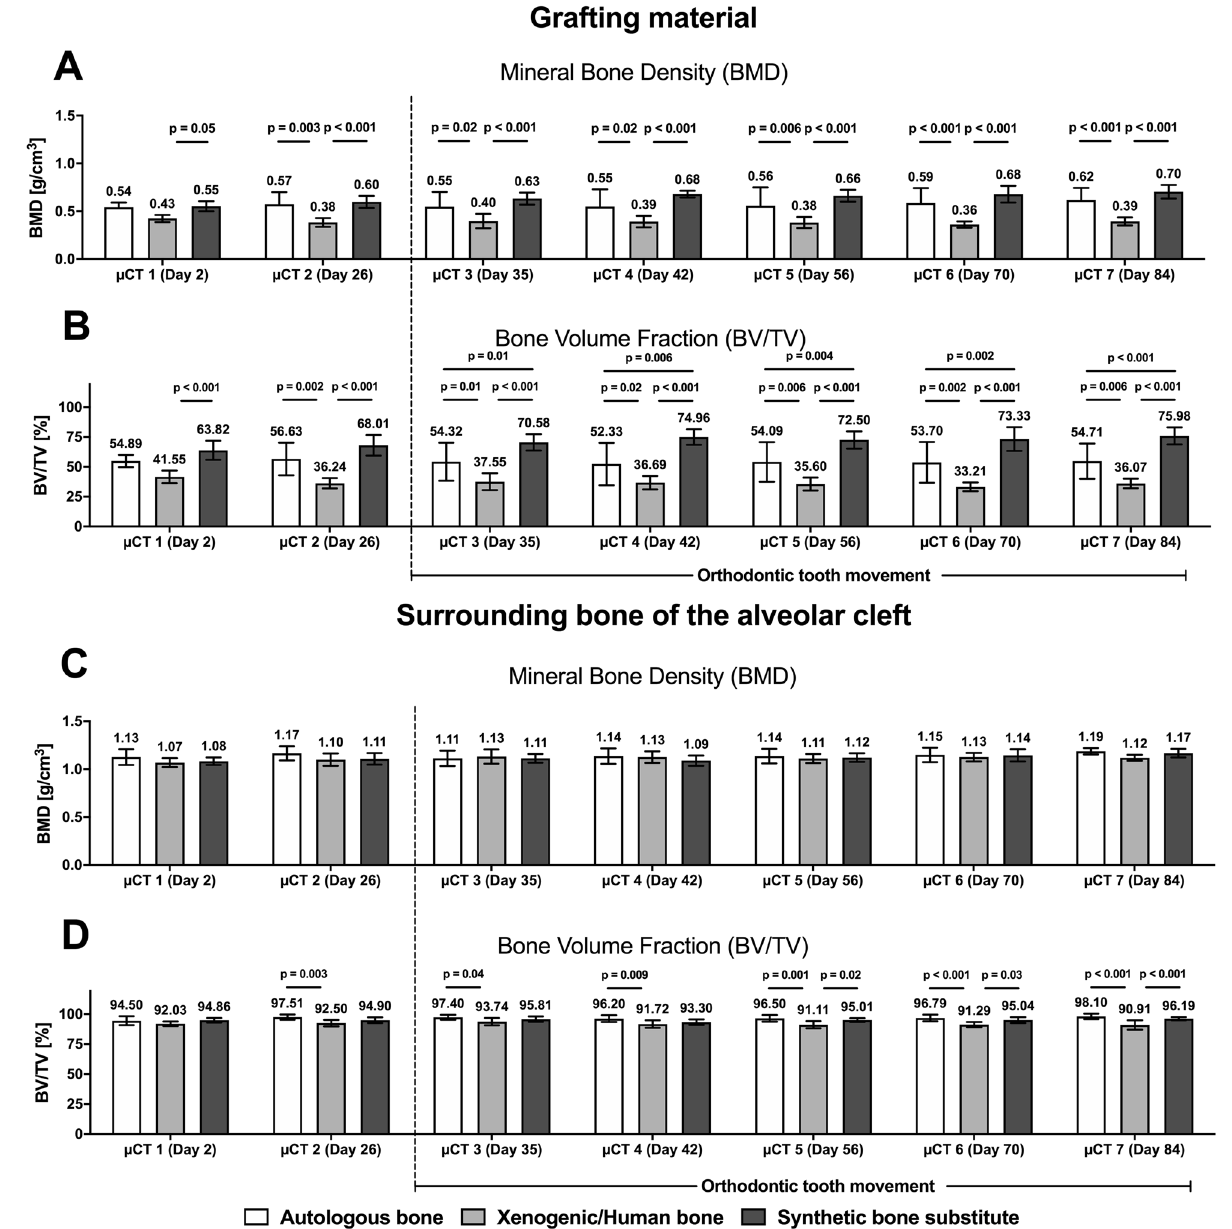
Figure 7. Radiological changes of the bone mineral density (BMD) and bone volume fraction (BV/TV) in the grafting materials ( A , B ) and in the bone surrounding the cleft ( C , D ) of the maxillary reconstruction: column bars of the mean values and p-values for the comparisons between the three different materials at seven points in the 84-day healing period after cleft